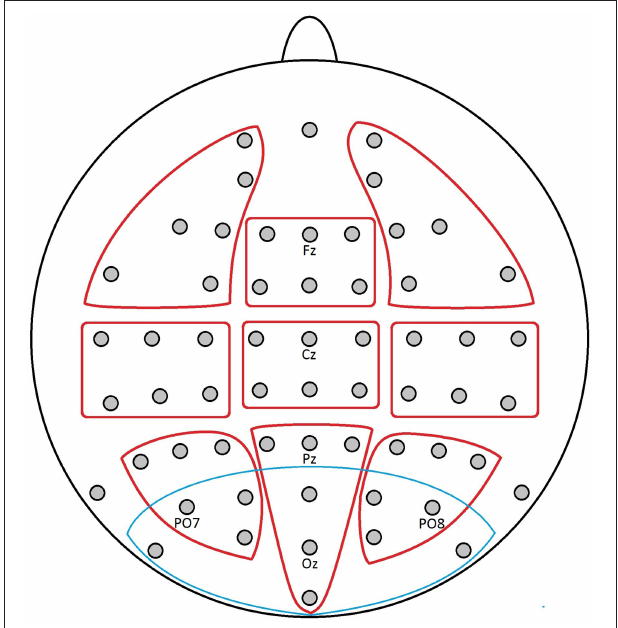
FIGURE 1 | Electrode positions of the applied 10–20 system with marked topographic clusters (ROIs) as used in the analyses: red, exploratory topographic clusters; blue, EPN